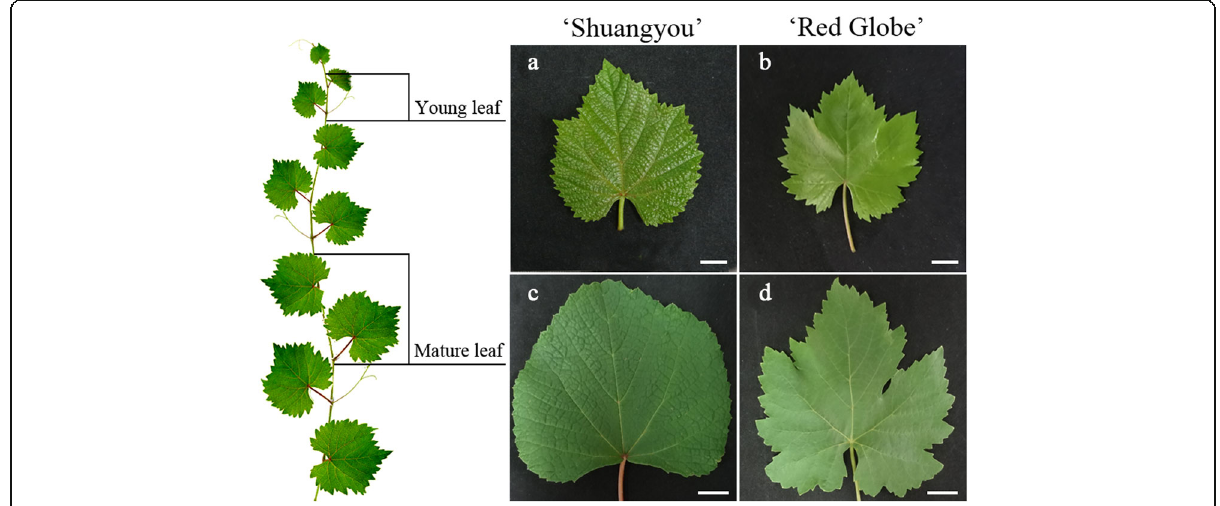
Fig. 1 Foliar morphology of young ( a , b ) and mature leaves ( c , d ) from V . vinifera cv. Red Globe and V . amurensis cv. Shuangyou. Bars: a , b = 1 cm, c , d = 2 cm